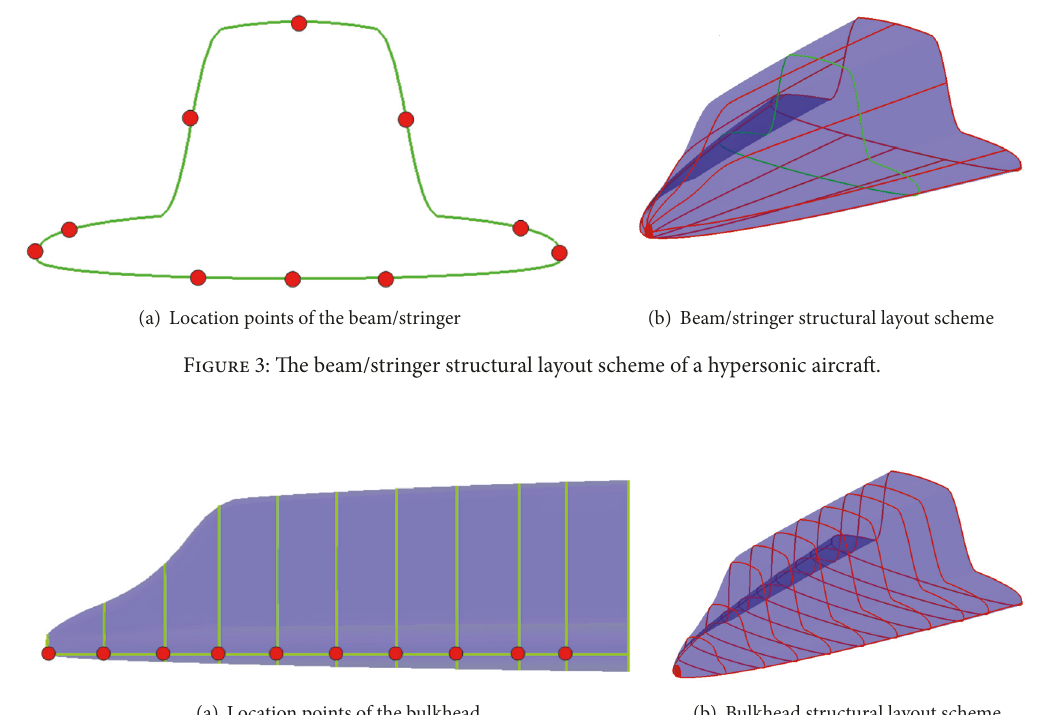
Figure 4: The bulkhead structural layout scheme of a hypersonic aircraft.